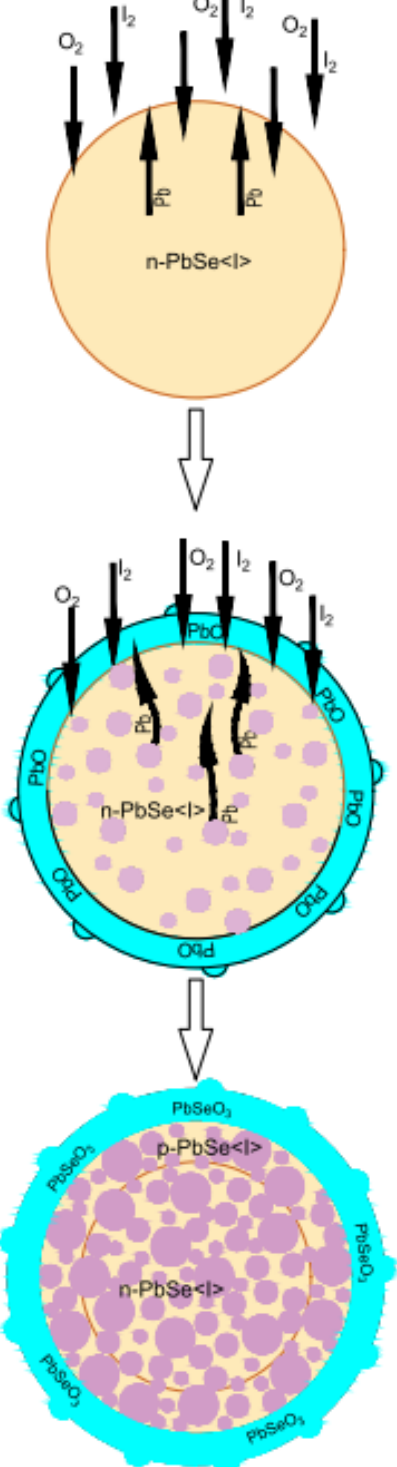
Figure 6. The oxidation process of n-PbSe grain with the presence of iodine in charge and in atmosphere during the annealing (forming voids are schematically shown as a purple